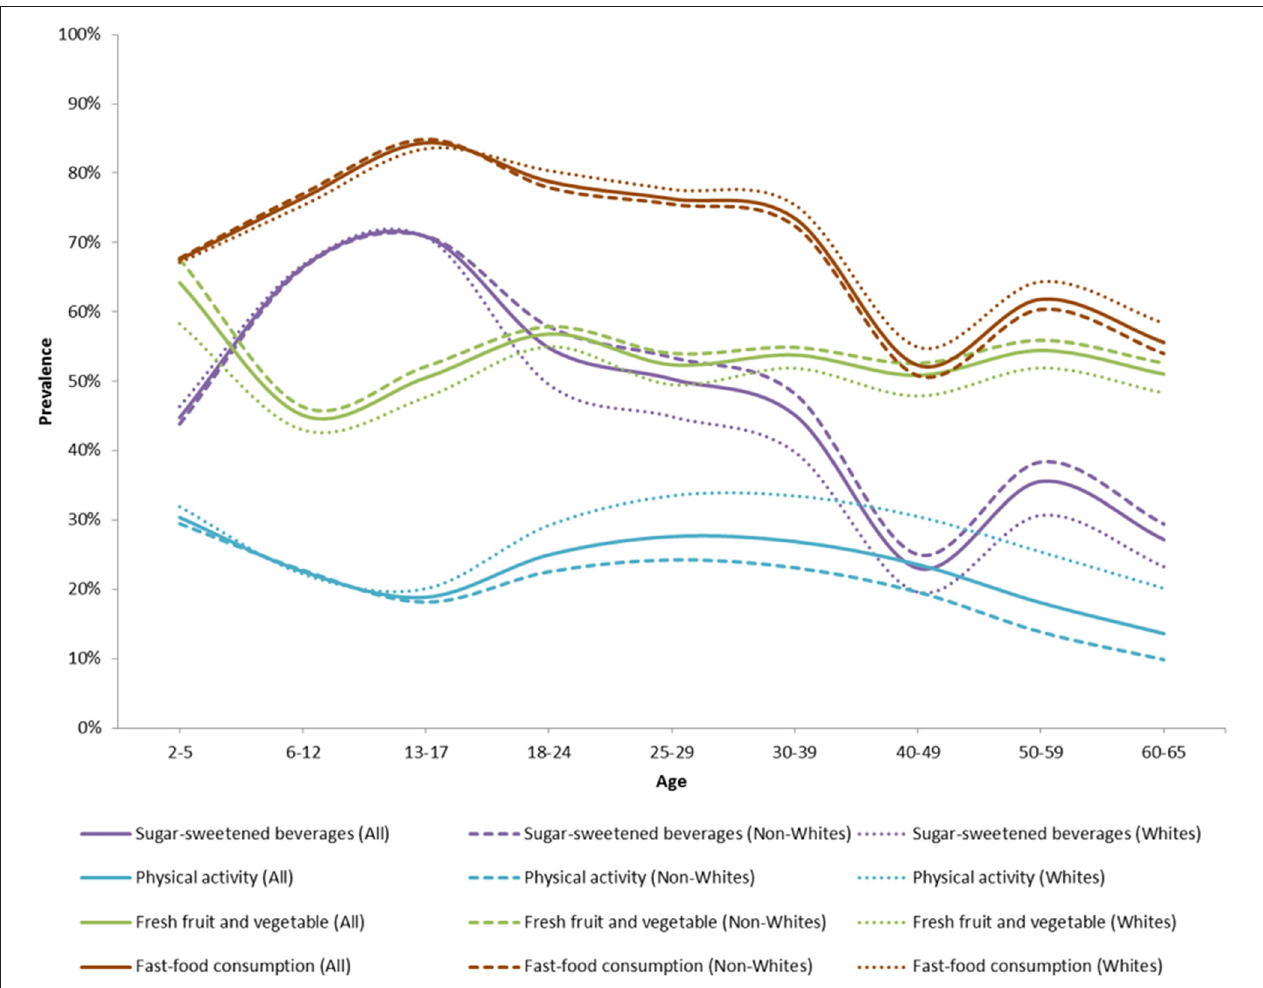
FIGURE 6 | Proportion of obesity- and type 2 diabetes-related health behaviors over time in the ViLA-Obesity model. This figure highlights the health behaviors prevalence across the population.